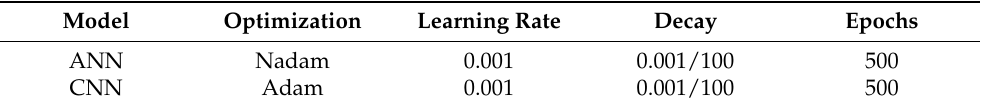
Figure 6. Typical architectures of the OBIA-CNN integration frameworks identified in this research. Table 3. Parameters used to train the base